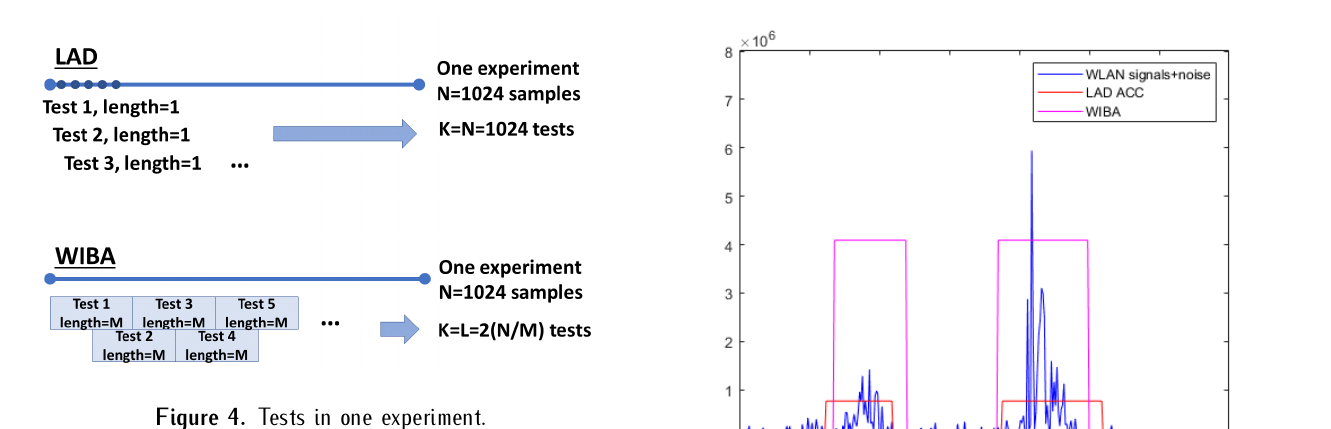
Figure 4. Tests in one experiment. Table 2. Corresponding LAD false alarm rate values P f a,desWIBAnew for the WIBA method for different values of L . Figure 5. Measured WLAN signals detected using the LAD ACC and WIBA